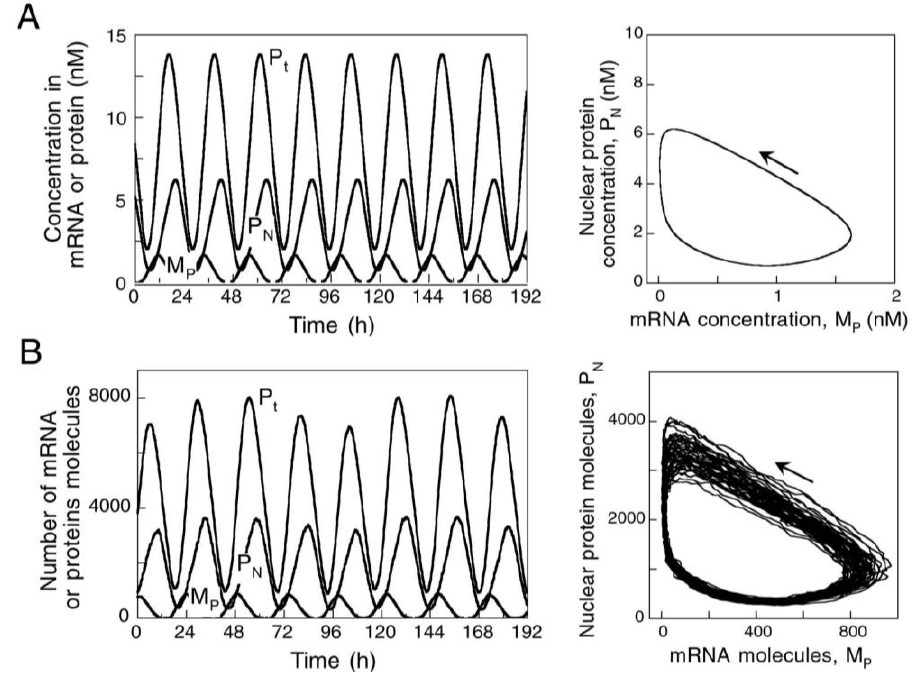
Figure 8. Effect of molecular noise on circadian oscillations during genetic expression. ( a ) Periodic behaviors obtained by numerical integration of the deterministic model in absence of noise. ( Left ) The oscillatory patterns correspond to mRNA (M ), nuclear protein P (P ) and total clock protein (P ). ( Right ) Limit cycle obtained as a projection onto the N t P – M phase plane. ( b ) Robust circadian oscillations with a period of 24.4 h produced by N P the metabolic model in presence of noise. ( Left ) The number of mRNA molecules oscillates between a few and 1,000, whereas nuclear and total clock proteins oscillate in the ranges of 200–4,000 and 800–8,000, respectively. ( Right ) Stochastic simulations of the model yield oscillations that correspond, in the phase plane (P – M ) to the evolution of a N P noisy limit cycle. Reproduced with permission from PNAS